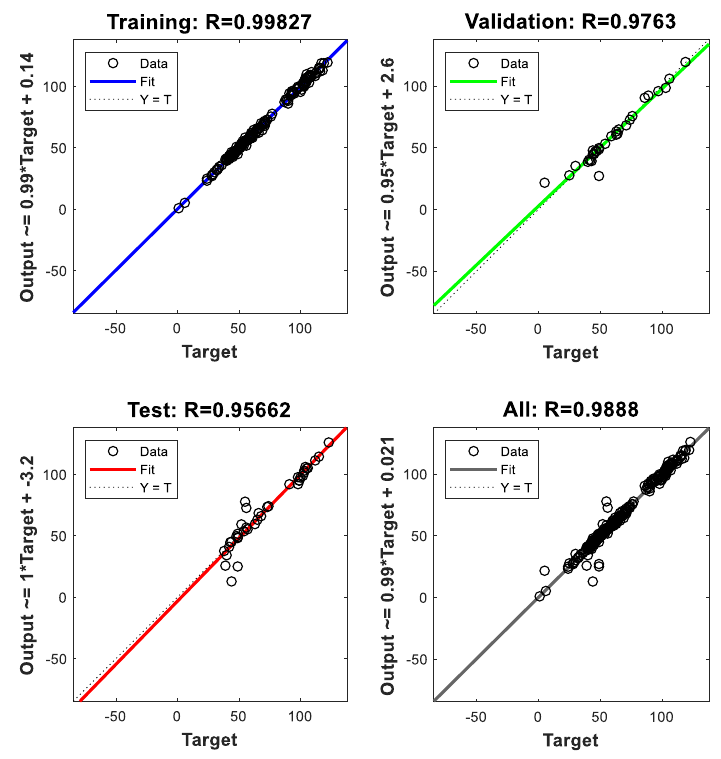
Figure 10. Regression analysis results.